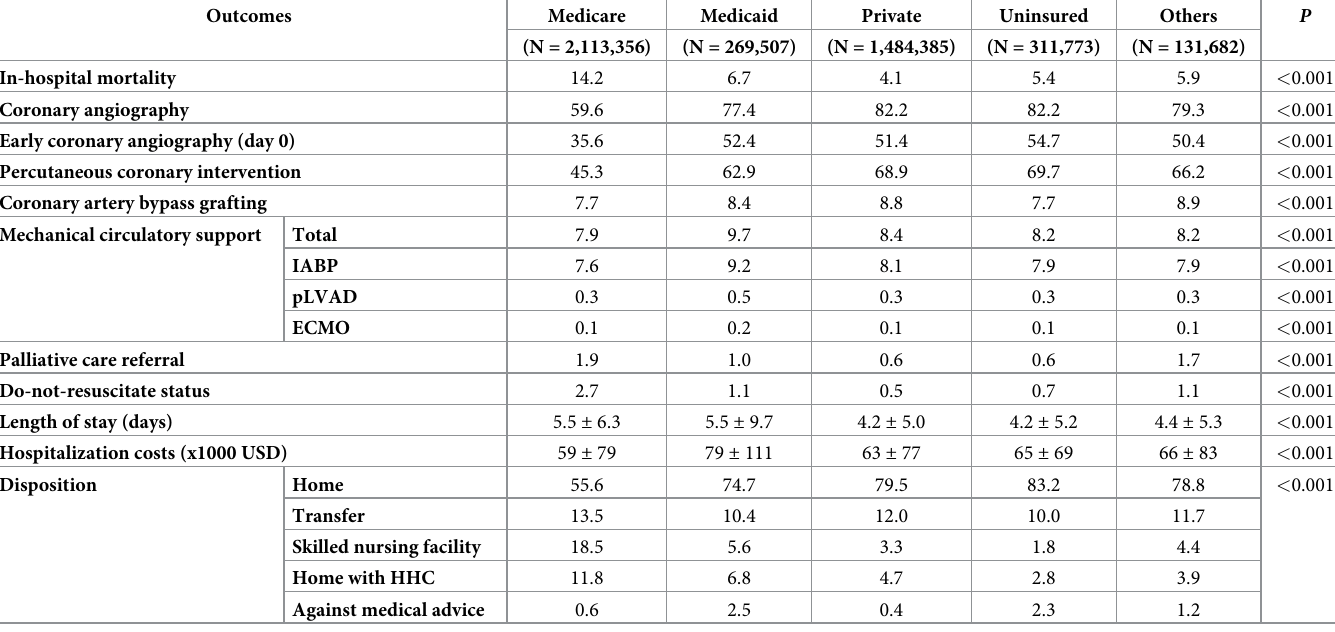
Table 2. Clinical outcomes of STEMI admissions stratified by primary payer